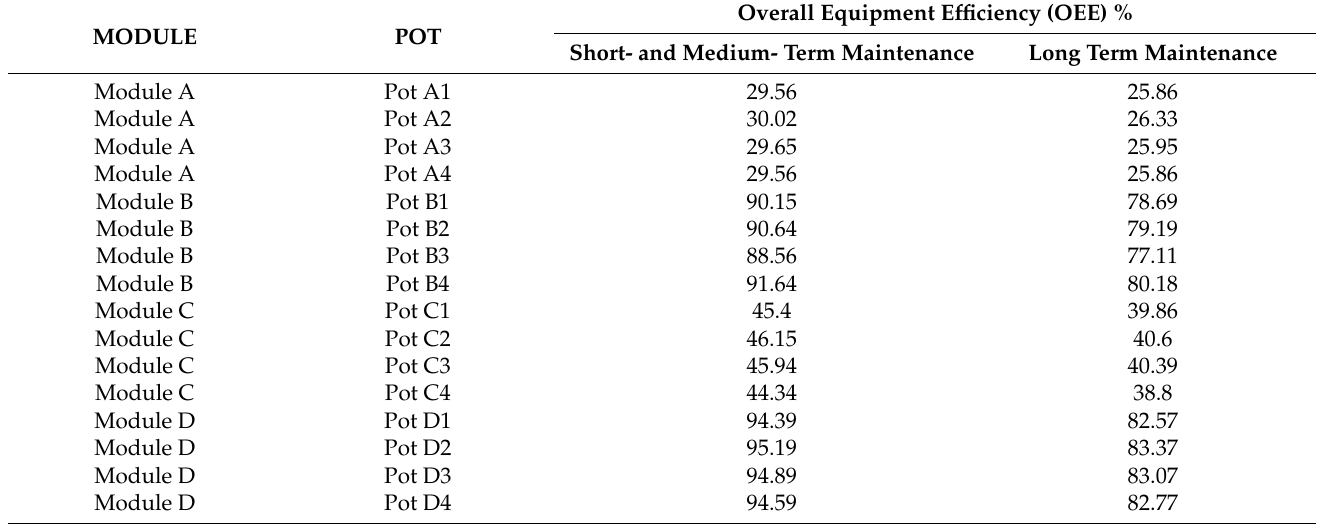
Table 2. OEE on the curing machine for four